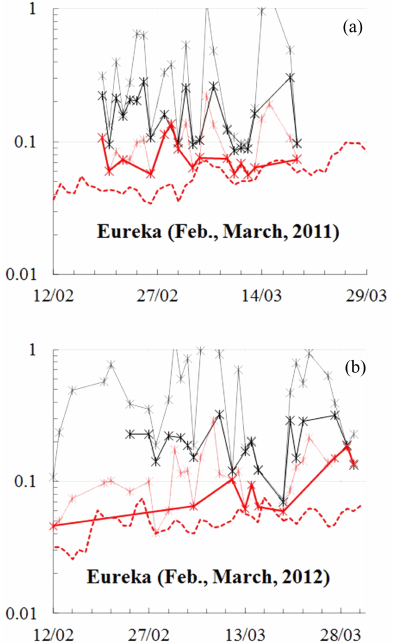
Figure 1. Comparison of measured and cloud-screened AODs (daily averages) derived from star photometry data with GEOS- Chem simulations over the polar winters of 2010/2011 and 2011/2012 at Eureka. The grey and black curves represent raw and cloud-screened AODs ( τ a and τ a , hom , respectively), while the light red and dark red curves represent the results of spectral cloud screening ( τ f and τ ∗ , respectively). In order to be included in Fig. 1, f all points required at least 10 raw AOD measurements per day. The simulated GC estimates of fine-mode AOD ( τ f , GC ) are shown as dashed red curves (see nomenclature details in the symbol and acronym